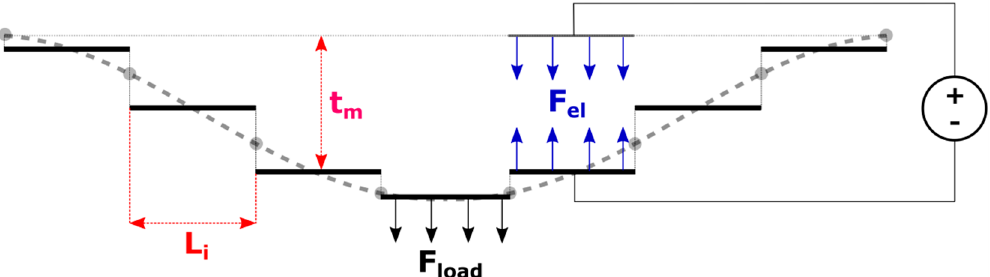
Figure 2. Methodology of electrostatic forces calculation in simulation.